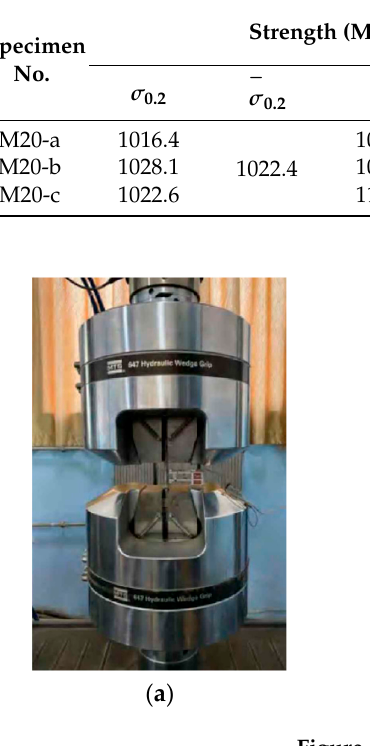
Figure 3. Dimensions and a photograph of test specimens (unit: mm). ( a ) Dimensions. ( b ) A photograph. Table 1. Measured material properties of bolts.